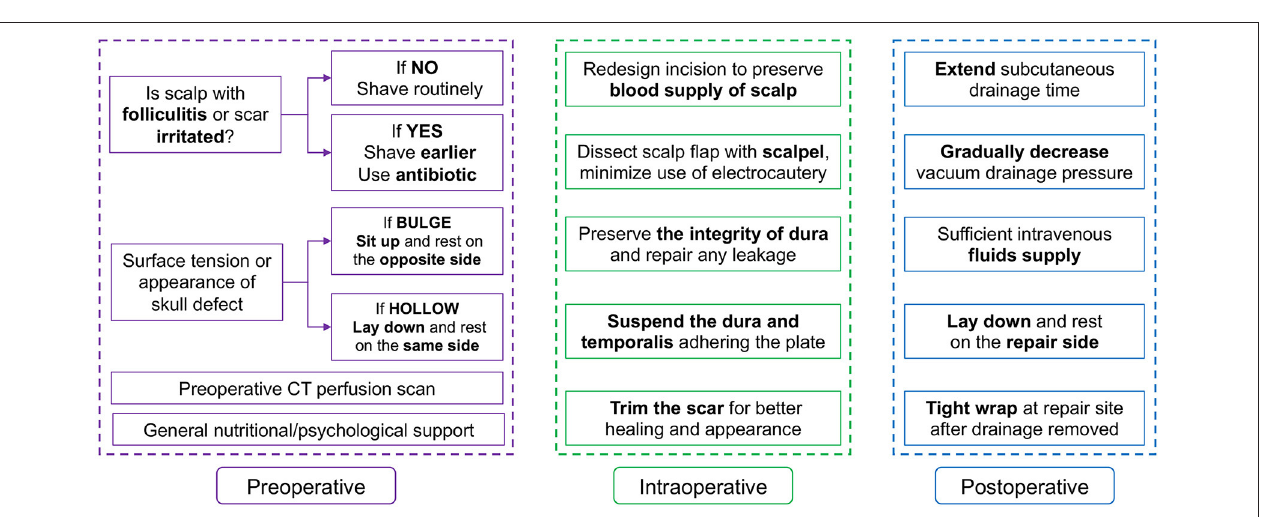
FIGURE 5 | Summary of comprehensive perioperative managements.